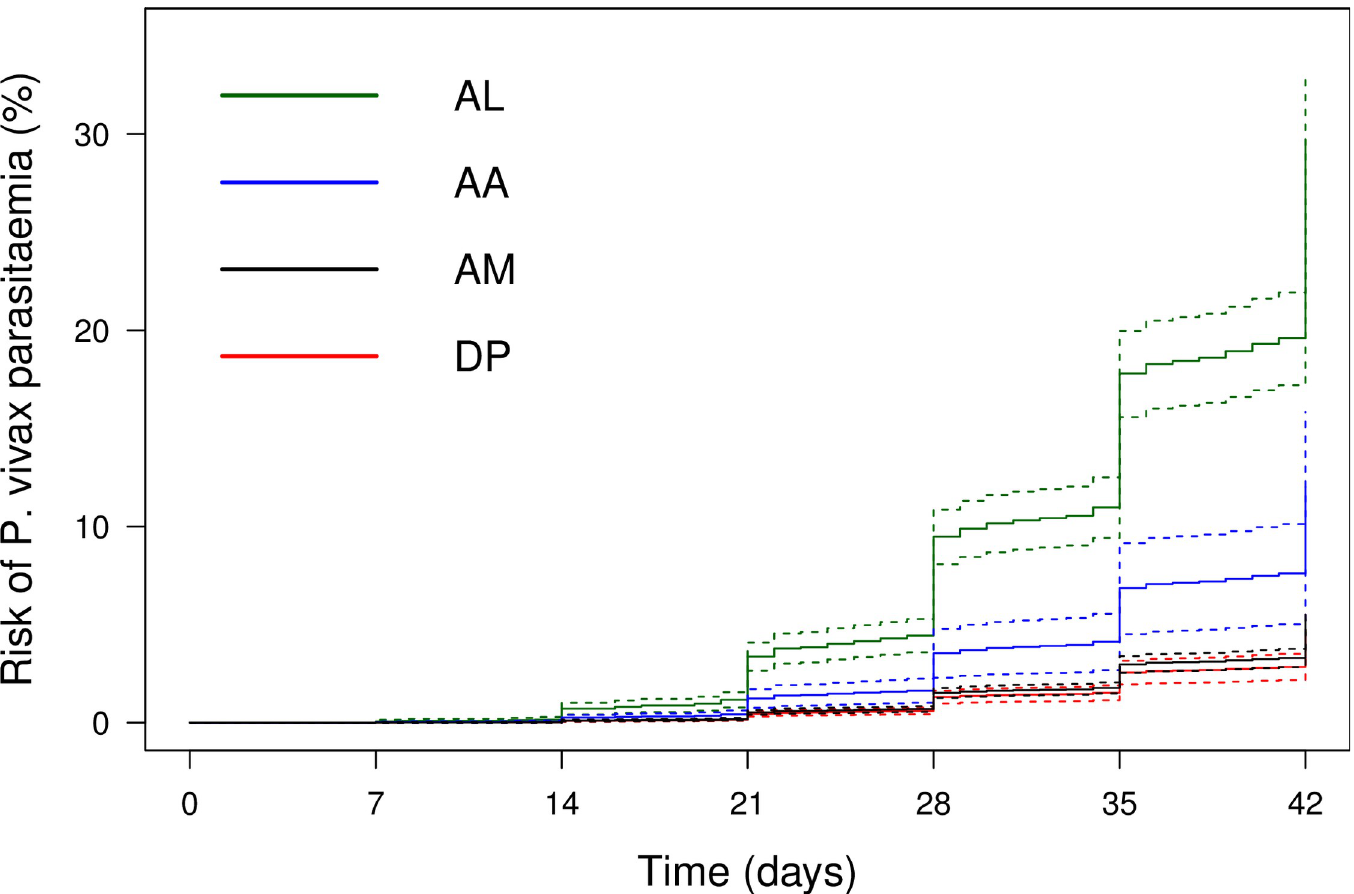
Fig 7. Risk of P . vivax parasitaemia following falciparum infection between day 7 and day 42 according to treatment. Dotted lines demonstrate 95% CIs. Figure adjusted for age, sex, baseline parasitaemia, regional relapse periodicity, P . falciparum gametocytes, mixed infection, and baseline Hb, assuming no study-site effect. AA, artesunate-amodiaquine; AL, artemether-lumefantrine; AM, artesunate-mefloquine; DP, dihydroartemisinin-piperaquine; Hb, haemoglobin.